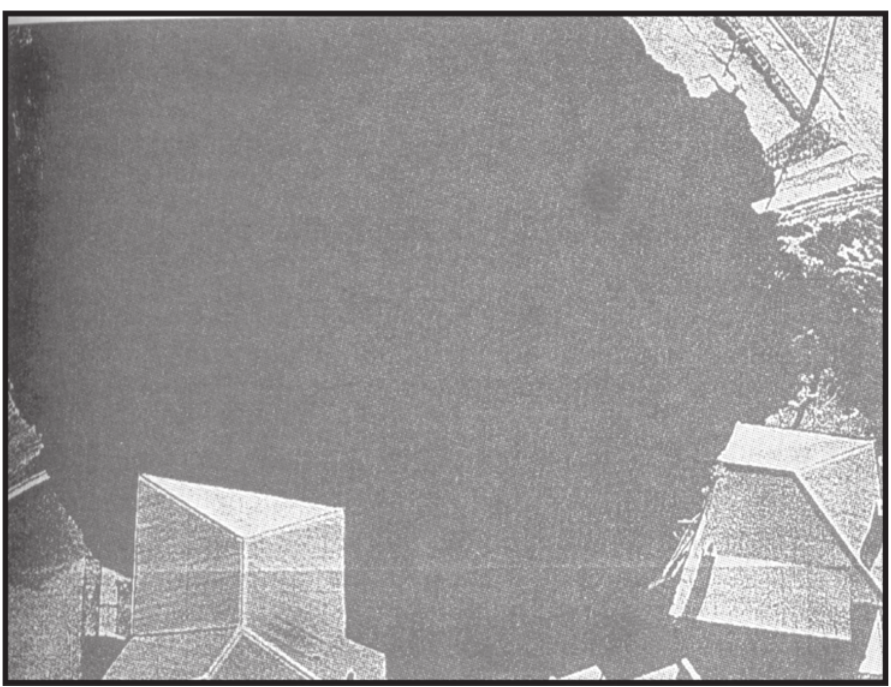
Illustration 3: The sinkhole on Blyvooruitzicht, August